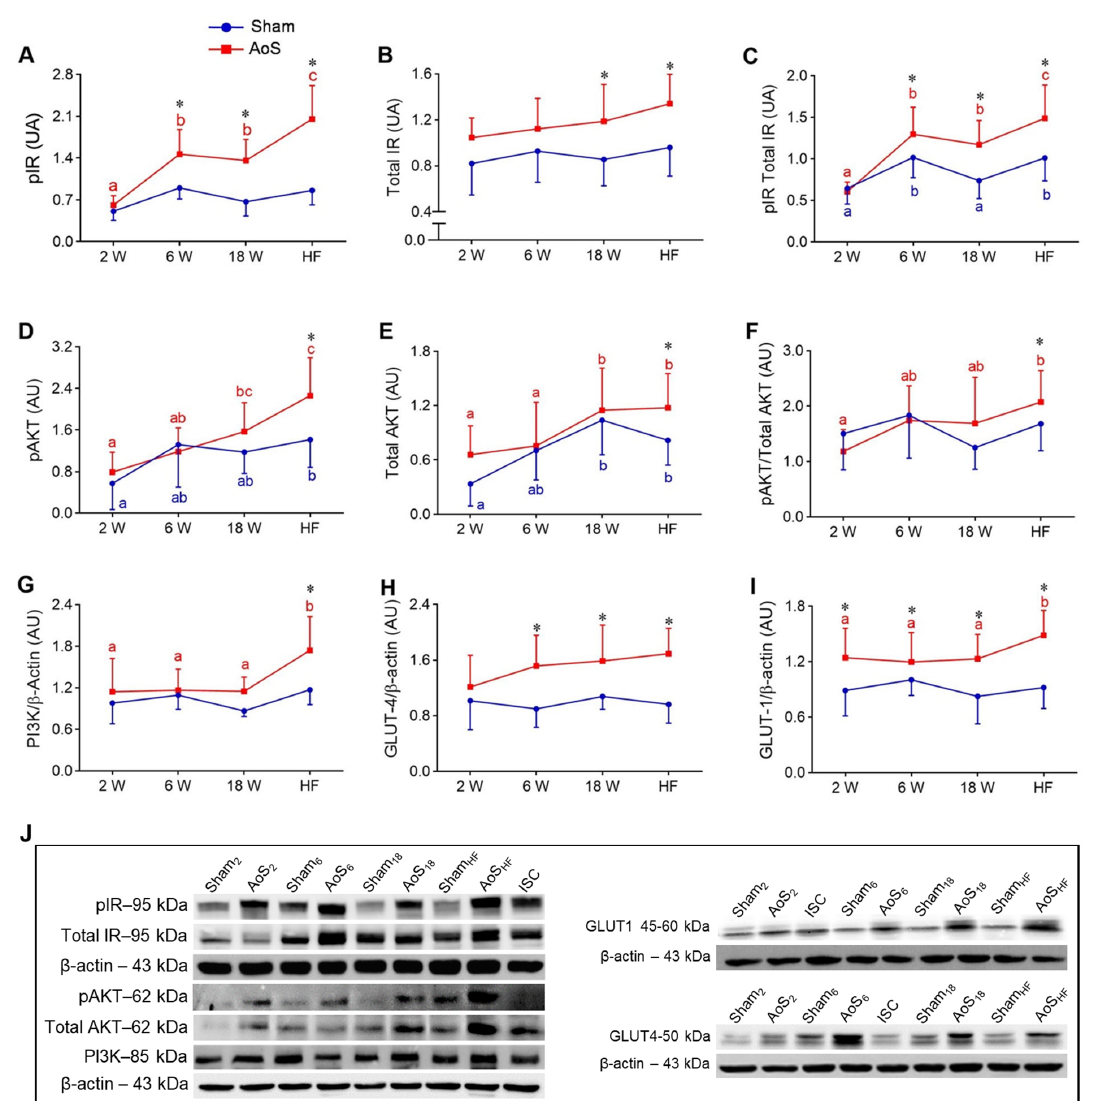
Figure 6. Cardiac insulin signaling and glucose transporters 1 and 4 at different euthanasia moments (2, 6, 18 weeks [W] and heart failure [HF]) evaluated by Western blot. Sham: operated control (blue); AoS: supravalvar aortic stenosis (red). Quantification of ( A ) pIR: phosphorylated insulin receptor, ( B ) Total IR: total insulin receptor, ( C ) pIR/Total IR: pIR/Total IR ratio, ( D ) pAKT: phosphorylated protein kinase B, ( E ) Total AKT: total protein kinase B, ( F ) pAKT/Total AKT: pAKT/Total AKT ratio; ( G ) PI3K: phosphoinositide 3 ‐ kinase, ( H ) GLUT4: glucose transporter 4, and ( I ) GLUT1: glucose transporter 1. ( J ) Representative bands of proteins. Data are expressed as mean ± SD and analyzed by ANOVA and Tukey. p < 0.05. * AoS vs. respective Sham. Distinct letters signify statistical difference between moments ( n = 8 animals for each